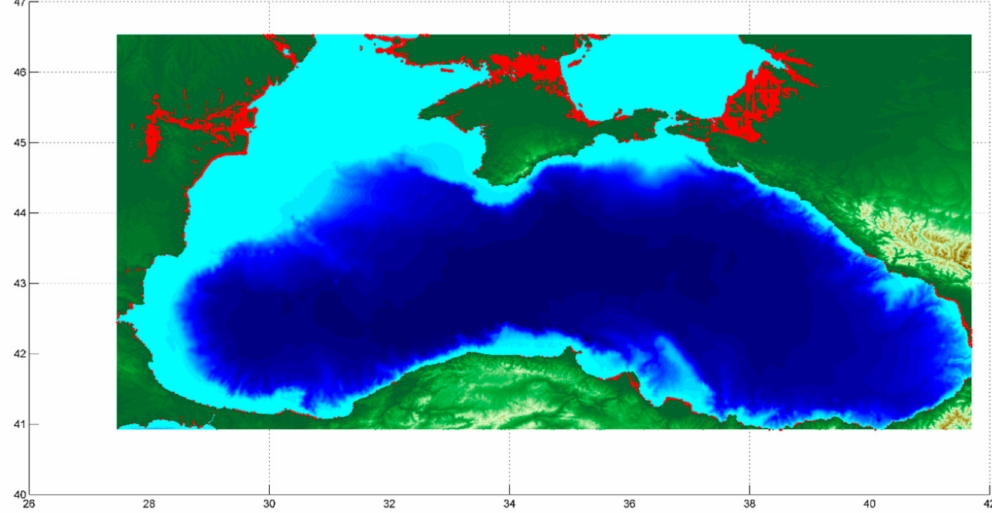
Figure 8. Coastal areas under water (marked in red), if the sea level rises 1